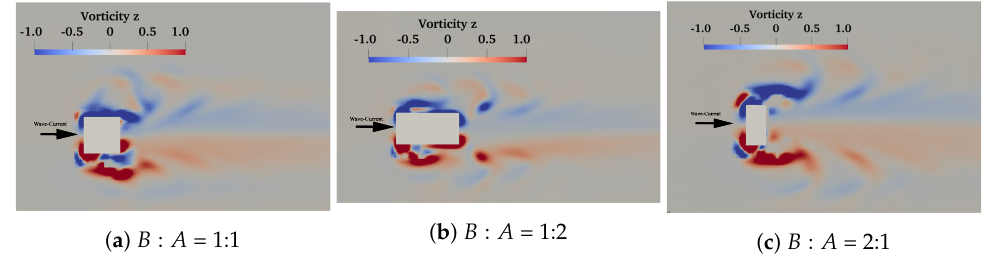
Figure 12. Vorticity contours for KC number = 3.9 and wave − current parameter ( U cw = 0.4) for varying aspect ratios of the rectangular pile.